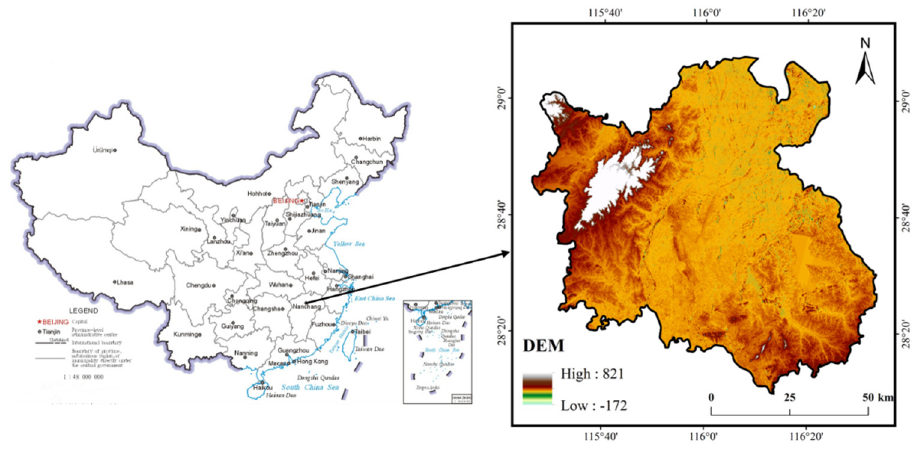
Figure 1. The study area.